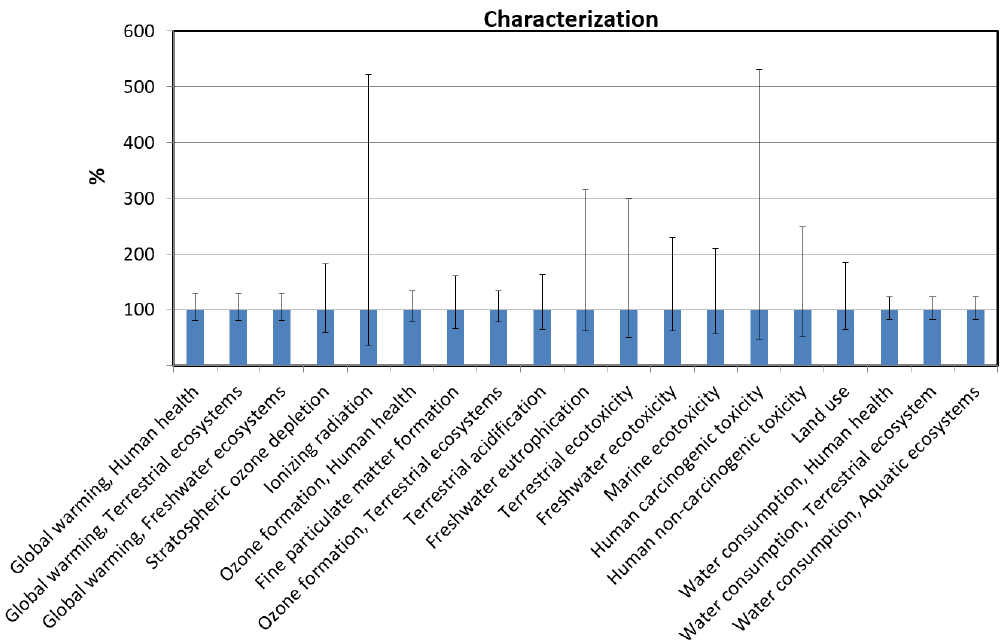
Figure 15. Uncertainty analysis outcome for NiMH